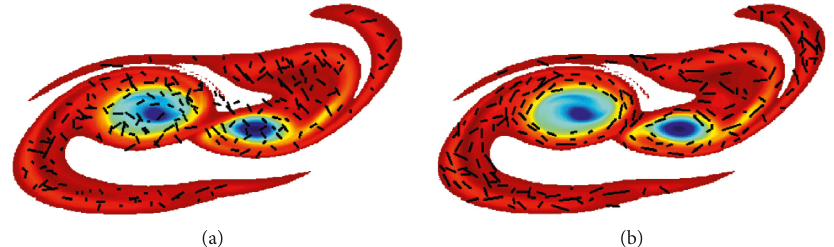
Figure 4: Particle distribution for different Stokes numbers ( t � 100, Re � 200, and a � 15): (a) St � 0.02 and (b) St � 1.0.